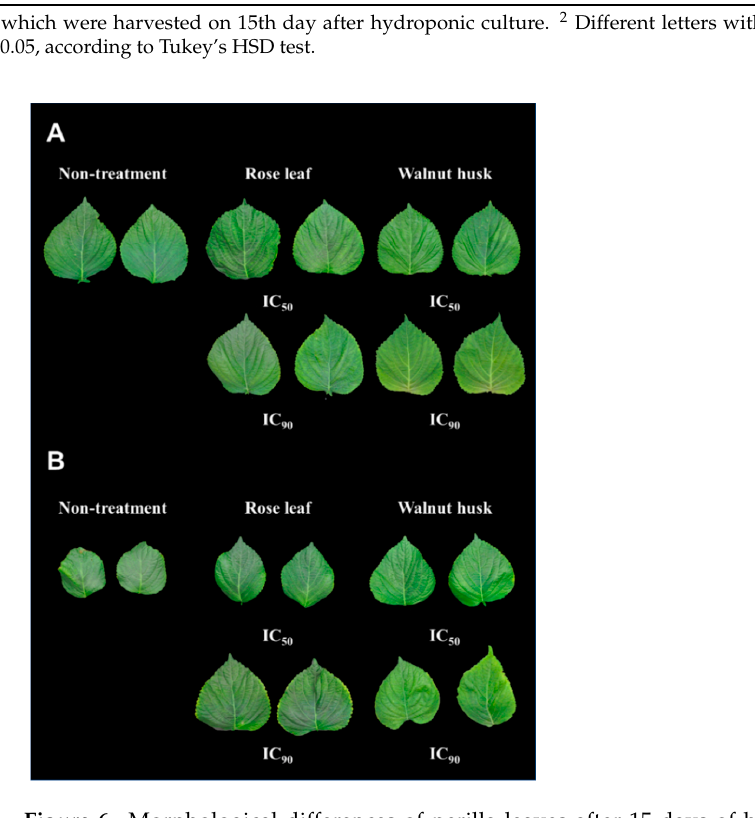
Figure 6. Morphological differences of perilla leaves after 15 days of hydroponic culture using ( A ) algae-free and ( B ) treated media with non-treatment, rose leaf, and walnut husk